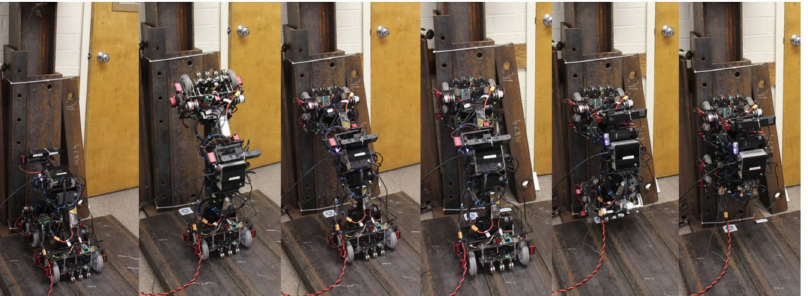
Figure 40. Inch-worm transformation of ARA robot on a steel bridge inspection test